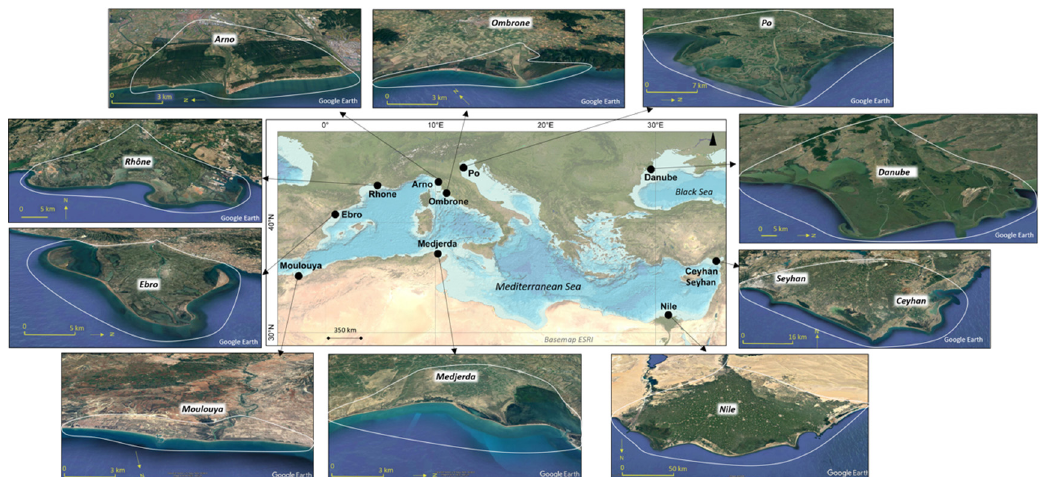
Figure 1. Map of the Mediterranean and Black Sea showing the ten river deltas selected for this study, and Google Earth images of each delta, with delimited buffers for the determination of land-water changes. The Ceyhan and Seyhan are considered here as a single